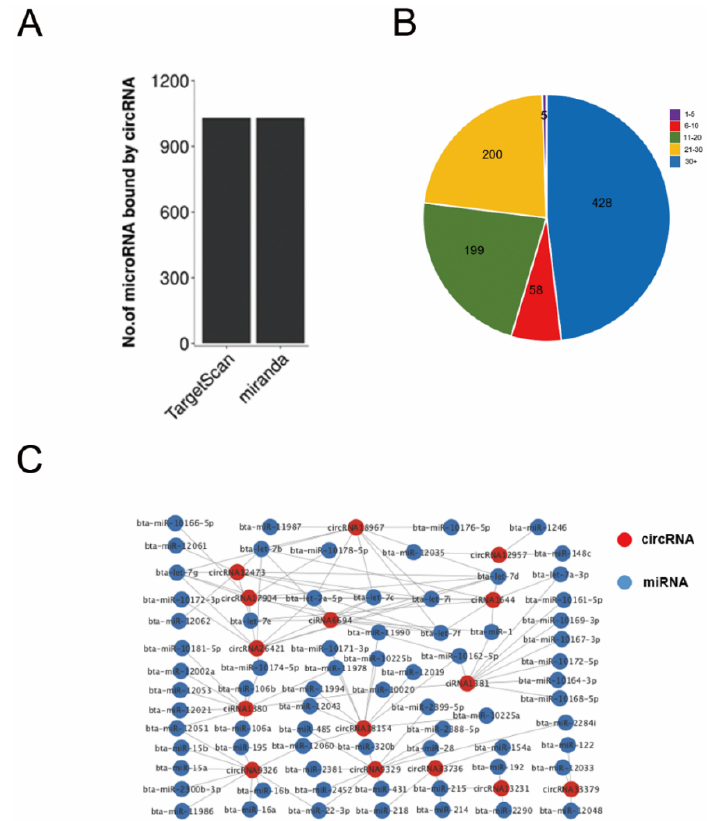
Figure 5. Analysis of interaction between DECs and miRNAs between P-Buffalo and C-Buffalo. ( A ) Analysis of the circRNAs for miRNAs with TargetScan and Miranda. ( B ) Identification of the percentages of circRNAs with different numbers of miRNA targets. ( C ) Analysis of the predicted target miRNAs for selected DECs identified in c and P. The circRNAs selected were picked from the top DECs. Red circles indicate circRNAs and blue circles show miRNAs.